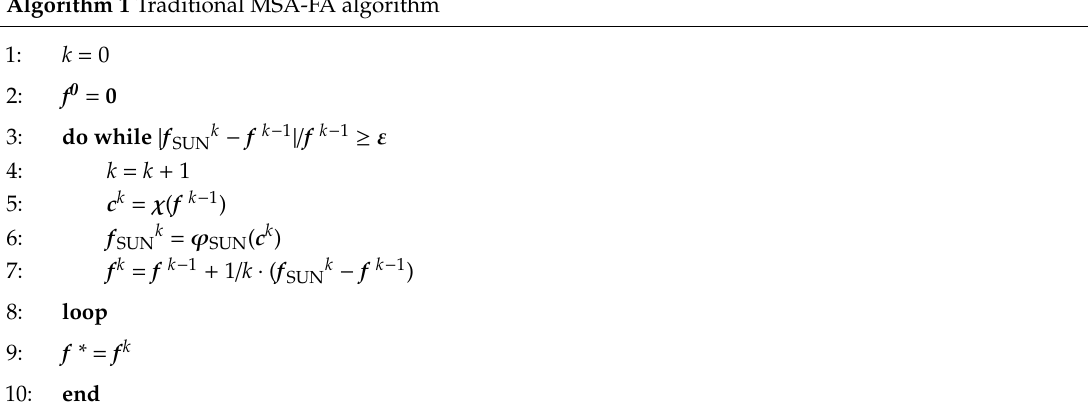
Algorithm 1 Traditional MSA-FA algorithm